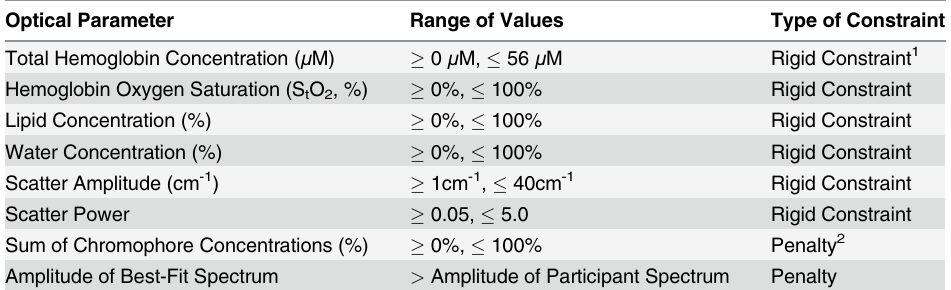
Table 1. Constraints and penalties employed in fi tting algorithm used to obtain chromophore concentrations and scattering